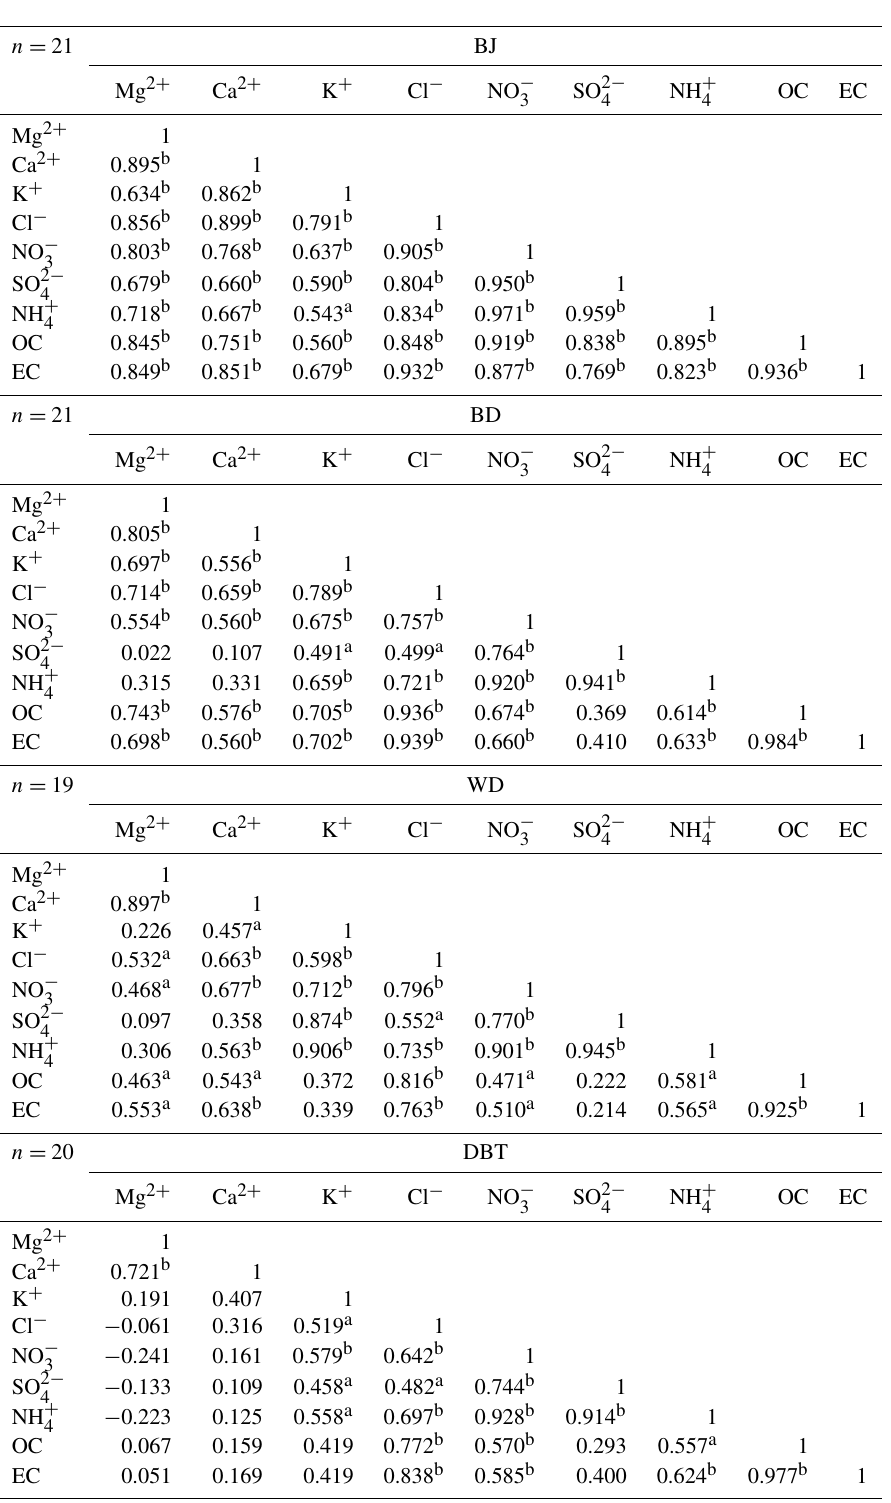
Table 4. The correlations of several typical species in PM 2 . 5 at the four sampling sites during the sampling period in the winter of 2015. n =